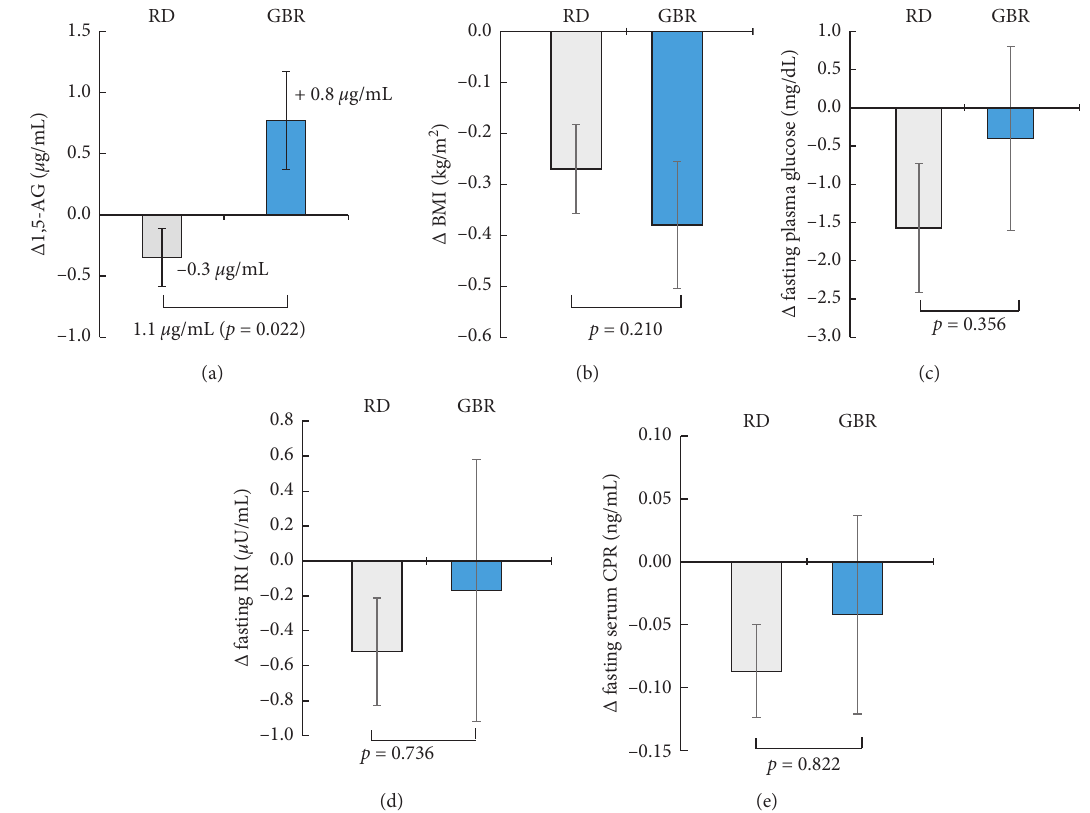
Figure 2: Change of the mean (a) serum 1,5-AG, (b) BMI, (c) FPG, (d) IRI, and (e) s-CPR between baseline and 6 weeks. Data are the mean ± standard error. Analysis of covariance (ANCOVA) including baseline value as a covariate and intervention group as fixed effect. The serum 1,5-AG was significantly increased in the GBR group and the mean treatment difference (GBR group − RD group) was1.1 µ g/mL ( p � 0 .